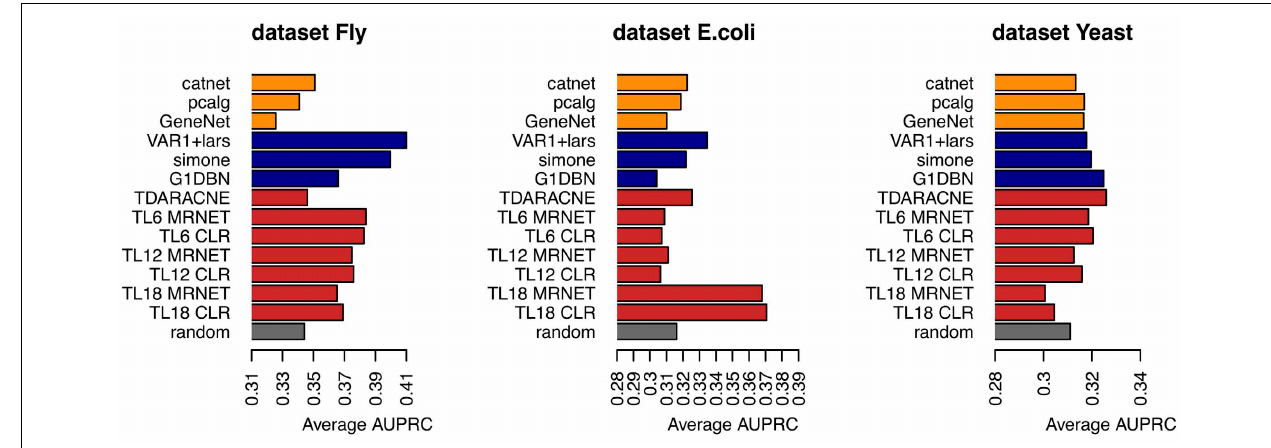
FIGURE 2 | Average AUPRC for the three datasets and different algorithms.